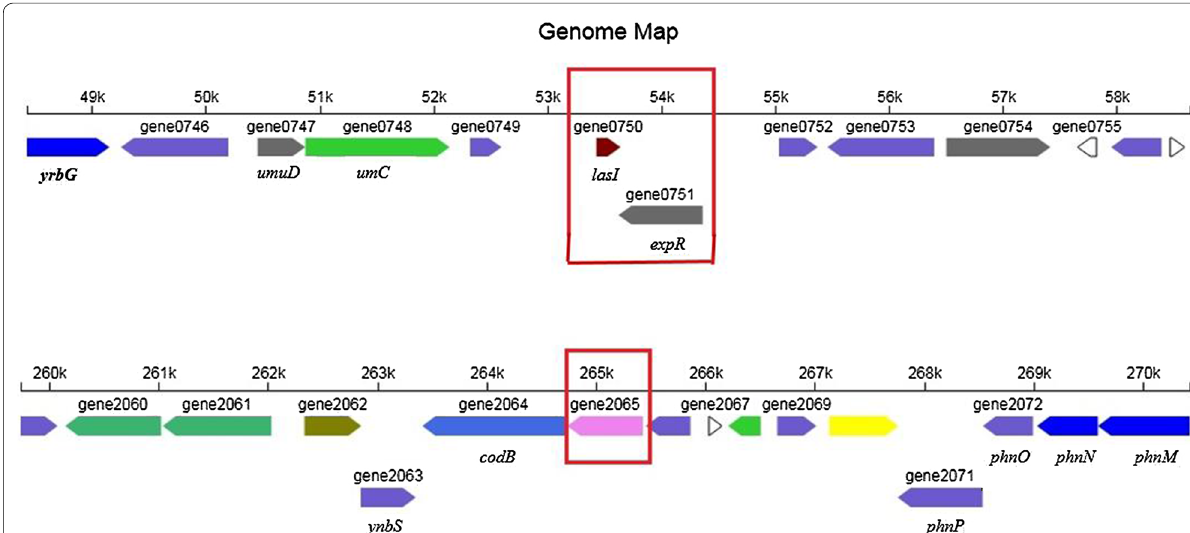
Fig. 3 Arrows indicate the direction of transcription of the gene. The number below the gene arrow is the locus tag corresponding to the genome. Different colors represent the predictive function of different genes. LuxI family AHL synthase gene: lasI (gene0750), brown; luxR family transcription factor gene: expR (gene0751), gray; another LuxR family transcription factor gene “solo R”: gene2065, pink